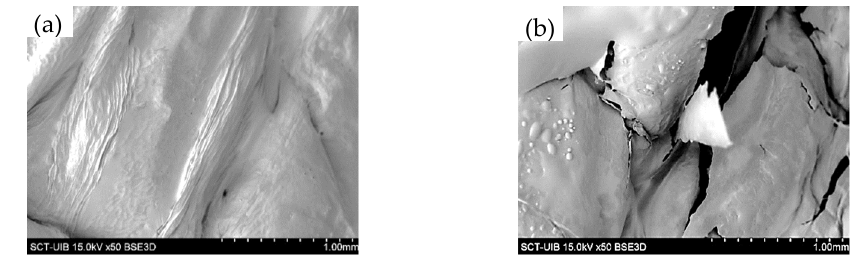
Figure 2. SEM images of red bell pepper samples: raw ( a ) and after 120 min of HPU treatment ( b ).